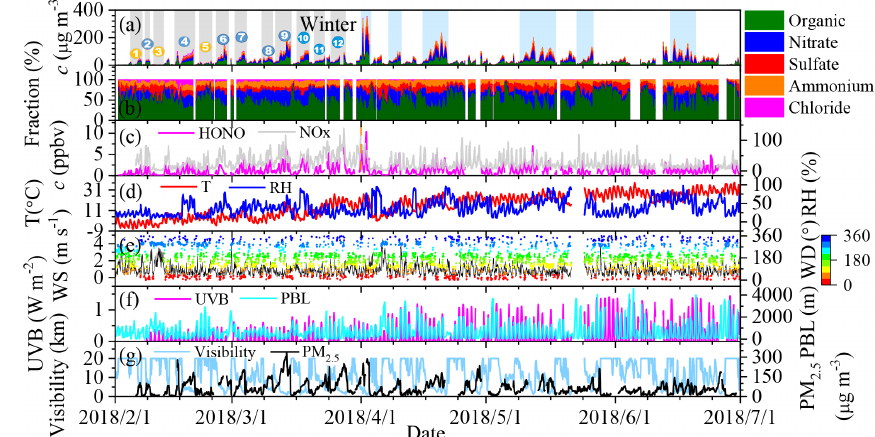
Figure 1. An overview of the measurement of the non-refractory-PM 2 . 5 (NR-PM 2 . 5 ), HONO, NO x , and PM 2 . 5 and meteorological parame- ters from 1 February to 1 July 2018. (a) The mass concentrations of the different components of PM 2 . 5 ; (b) the mass fraction of the individual components; (c) HONO and NO x concentrations; (d) temperature and RH; (e) wind speed and wind direction; (f) UVB and PBL heights; and (g) visibility and PM 2 . 5 concentration during the observations. We consider the period before 1 April to be winter. During the winter period, 12 cases were selected and numbered, including three clean cases (1, 3, and 5; in yellow) and nine pollution episodes